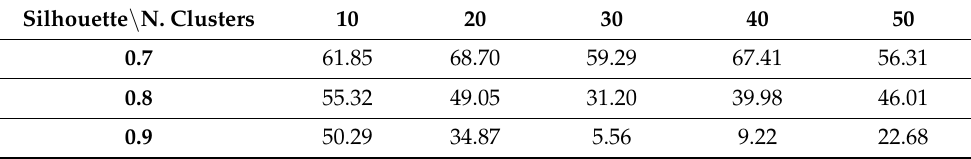
Table 7. Clustering performance in terms of silhouettes using original data. Silhouette \ N. Clusters